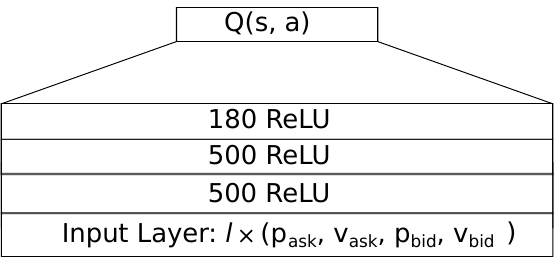
Figure 1. Our feedforward architecture.